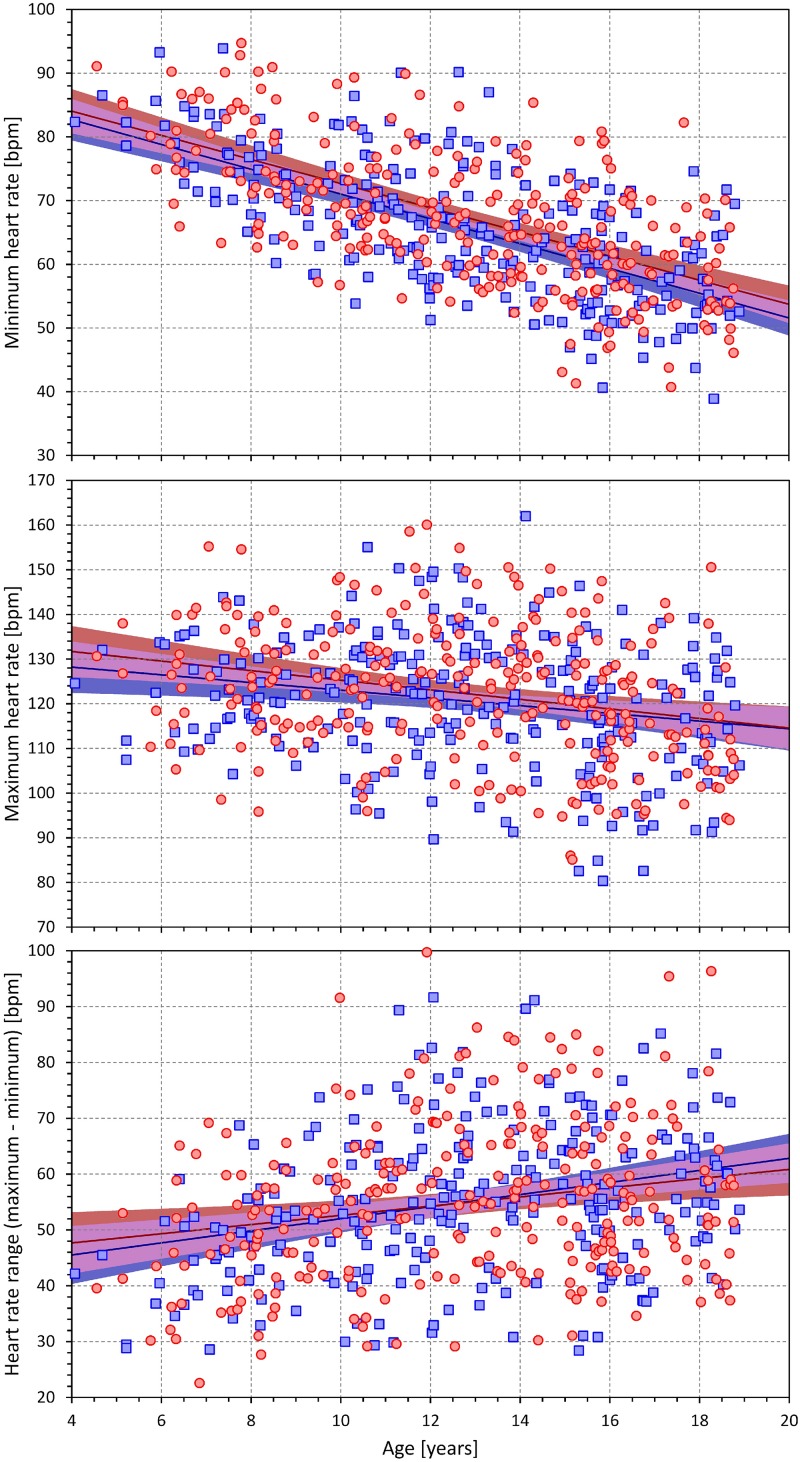
Scatter diagrams between the age and minimum heart rate (top) maximum heart rate (middle) and the range between the minimum and maximum heart rate (bottom). The layout and symbol definition in each panel are the same as in Figure 3.